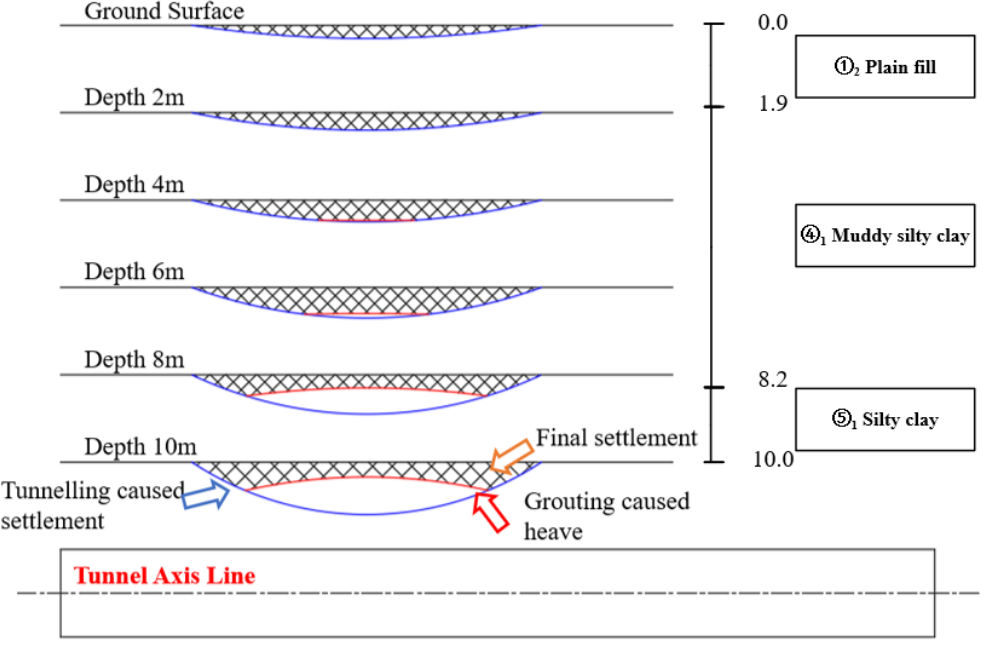
Figure 21. Figure of abnormal vertical displacement of stratum on the south line.